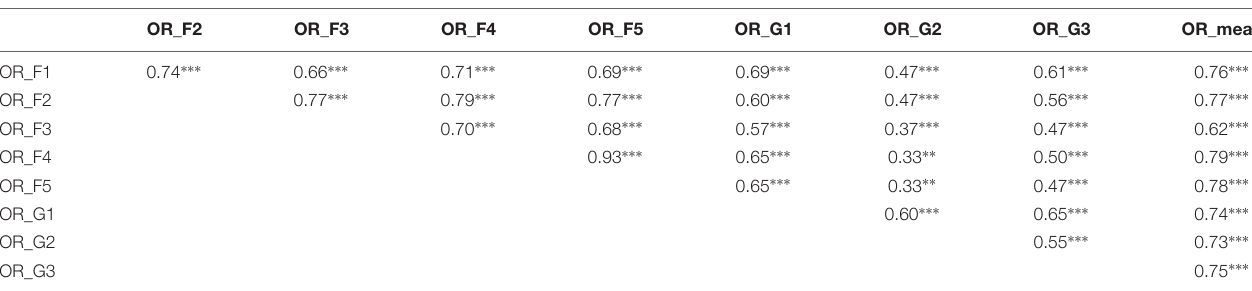
TABLE 2 | Pearson’s correlation coefficients among rust resistance reactions on the F 1 population derived from the cross CP95-1039 ×